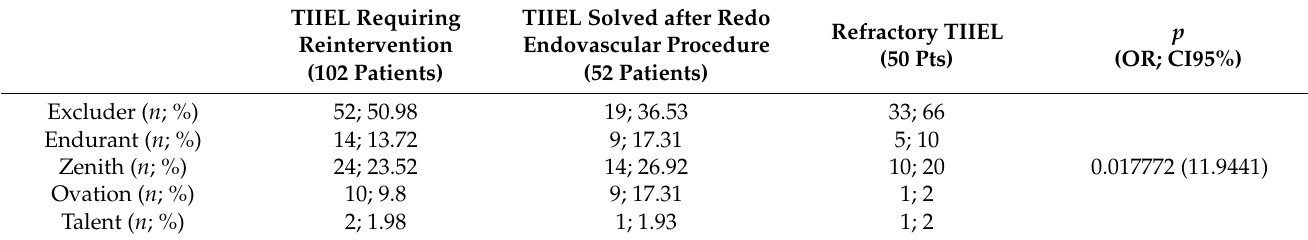
Table 3. Details of implanted endografts in present series.